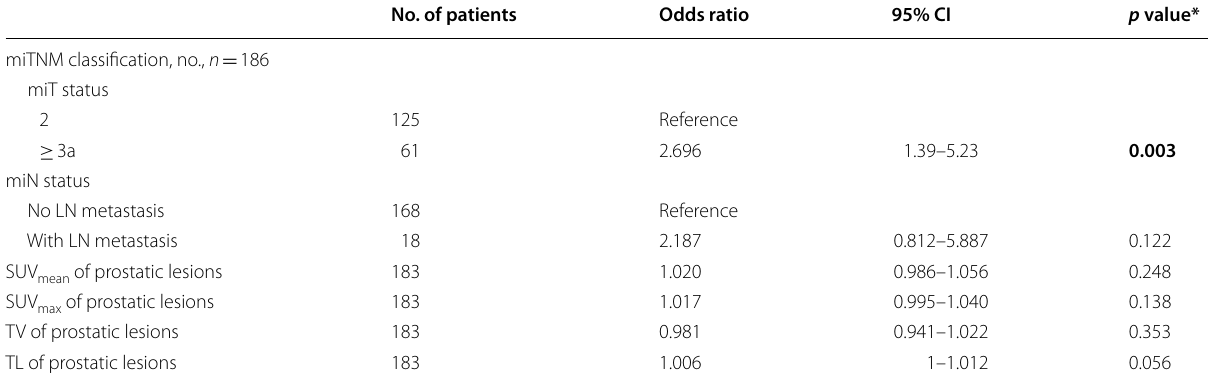
tional file 1: Fig. S2C) and negative surgical margins (log- rank, p < 0.001, Additional file 1: Fig. S2D).